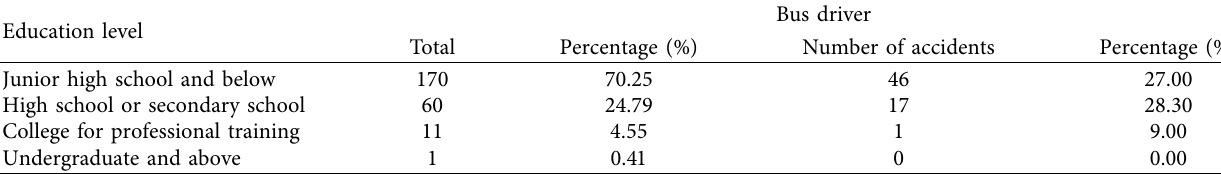
Table 5: Distribution of educational attainment.